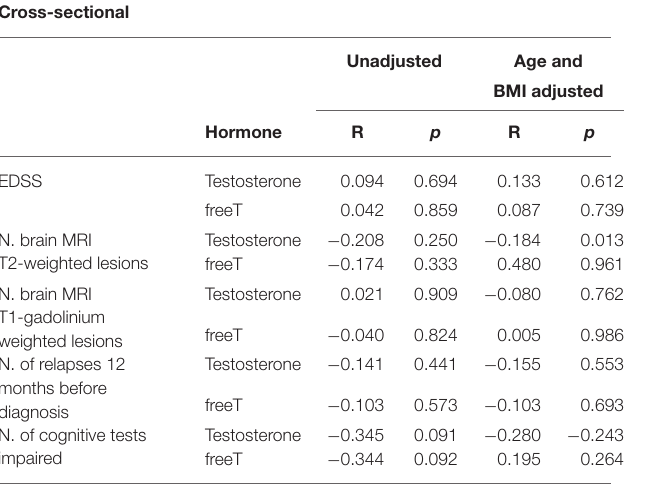
TABLE 3A | Association between baseline androgens and baseline clinical (EDSS. number of relapses 12 months before diagnosis), baseline radiological (N. MRI T2 and T1-gadolium weighted lesions) and n. of impaired tests cross-sectional outcomes. Cross-sectional